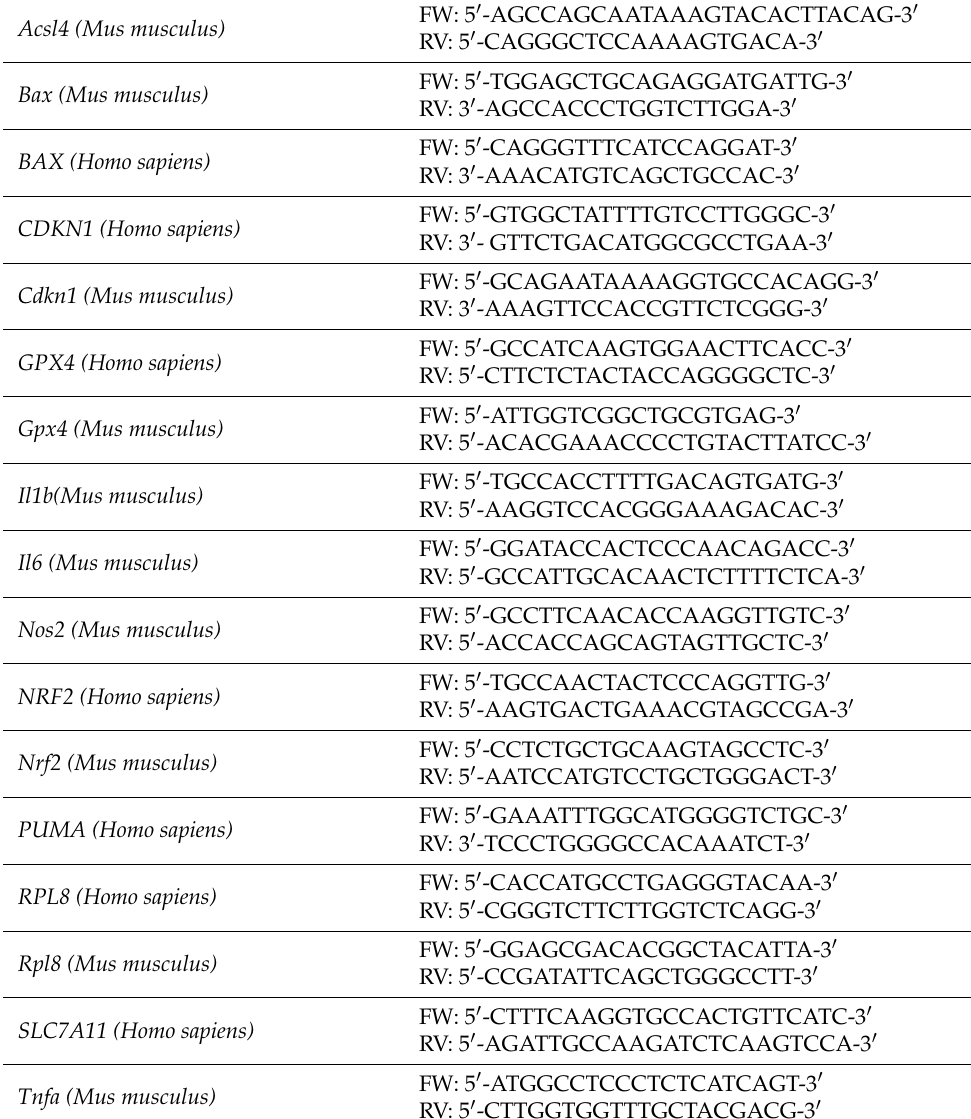
Table 1. Human and mouse primers used for RT-qPCR